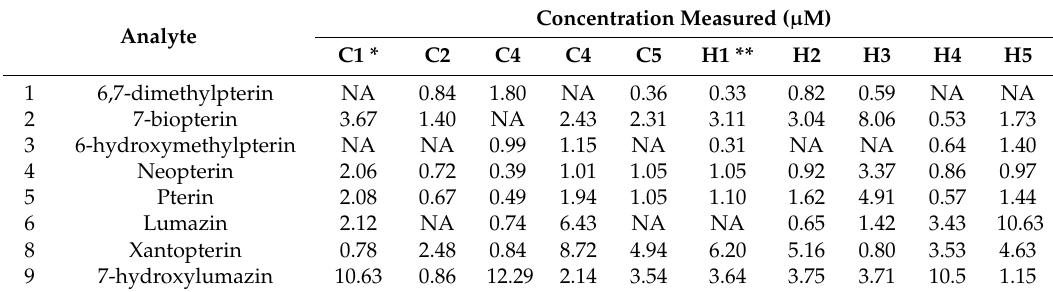
The concentration of pterins measured in urine samples from cancer patients and healthy